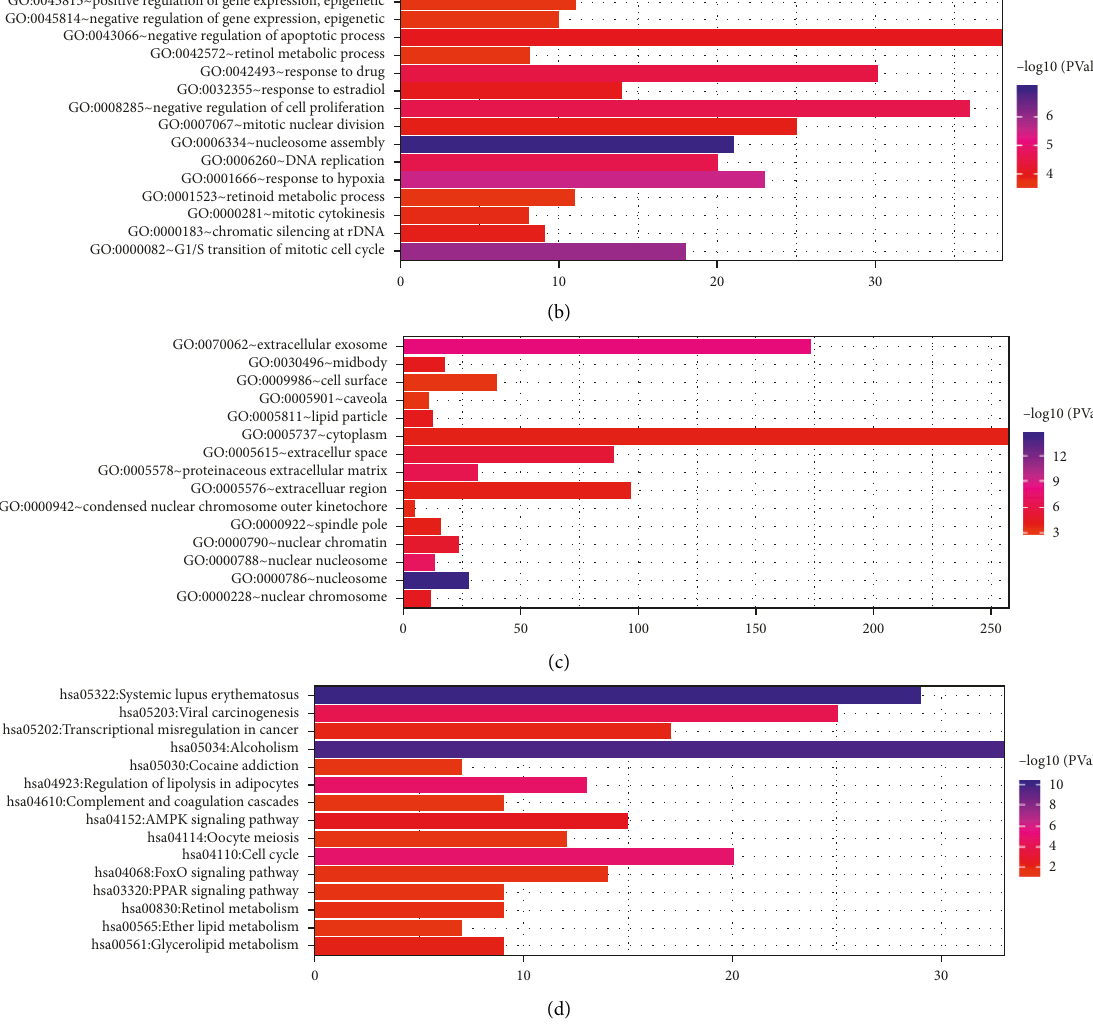
Figure 7: Top 15 significantly enriched GO terms and KEGG pathways of DEmRNAs coexpressed with DElncRNAs in luminal A breast cancer. (a) Biological process, (b) cellular component, (c) molecular function, and (d) KEGG